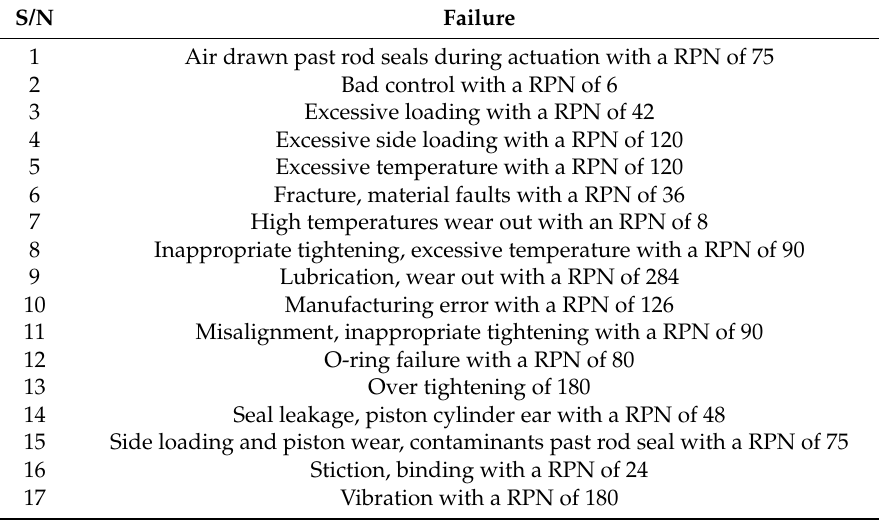
Table 5. Causes of failure ranked 1 to 17 in a decreasing order of criticality for pusher